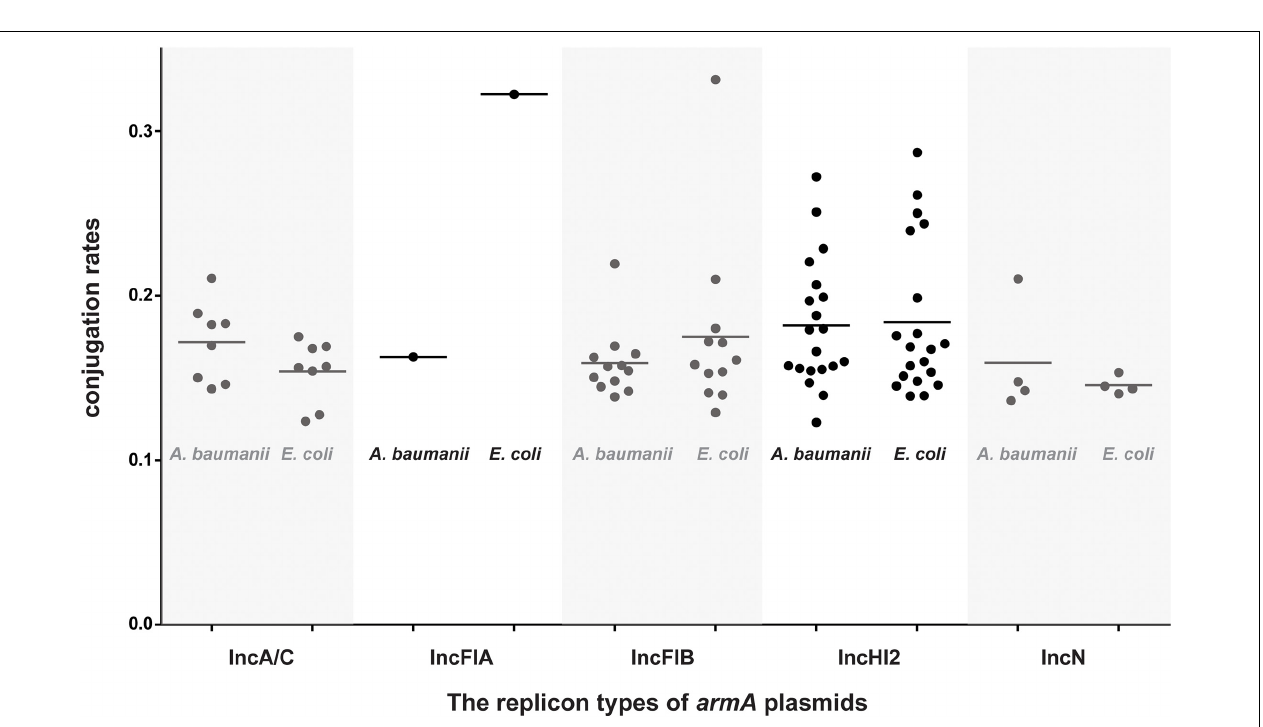
FIGURE 2 | Conjugation rates of the armA -harboring plasmids isolated in this study. All 45 detected armA -harboring Salmonella strains were used as the donors, and either E. coli J53 or A. baumannii was used as the recipient. Black circles show the 1/abs (log 10 transformation of the transfer frequency) data.